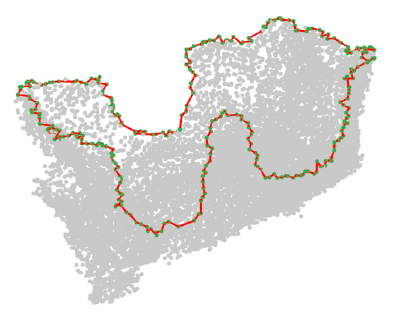
Figure 7. Example of hole boundary point connection.